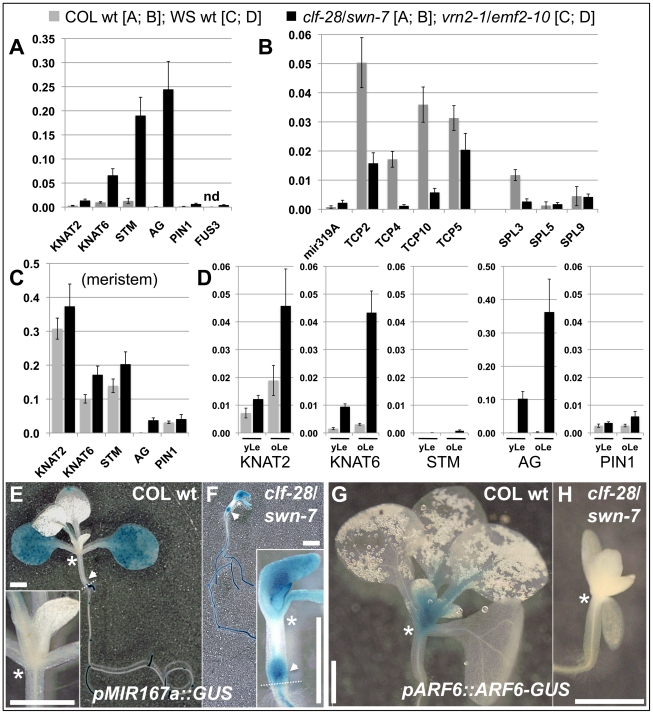
Pc-G proteins control tissue-specific expression of H3K27me3 target genes.(A) – (C) qRT-PCR based expression analyses of (A, B) 9 d old wildtype and clf-28/swn-7 plants or (C, D) 45 days old, dissected wildtype and vrn2-1/emf2–10 plants. Samples were enriched for meristem (Me) (C), young leaves (yLe, up to 3 mm blade length) or older leaves (oLe, 3 – 10 mm) (D). Expression values were normalized to At5g60390 (EF-1α). (E, F) Colorimetric analyses of pMir167a::GUS expression in 9 d old wildtype (E) and clf-28/swn-7 double mutants (F). Insets are close-ups. (G, H) Expression of pARF6::ARF6-GUS 9 d old wildtype (G) and clf-28/swn-7 double mutants (H). pARF6::ARF6-GUS carries the mir167 binding site. Asterisks mark meristematic region, white arrow base of hypocotyl. The border between the hypocotyl and the root is indicated with a dashed white line. Scale bars indicate 1 cm. All plants were grown in short day conditions.